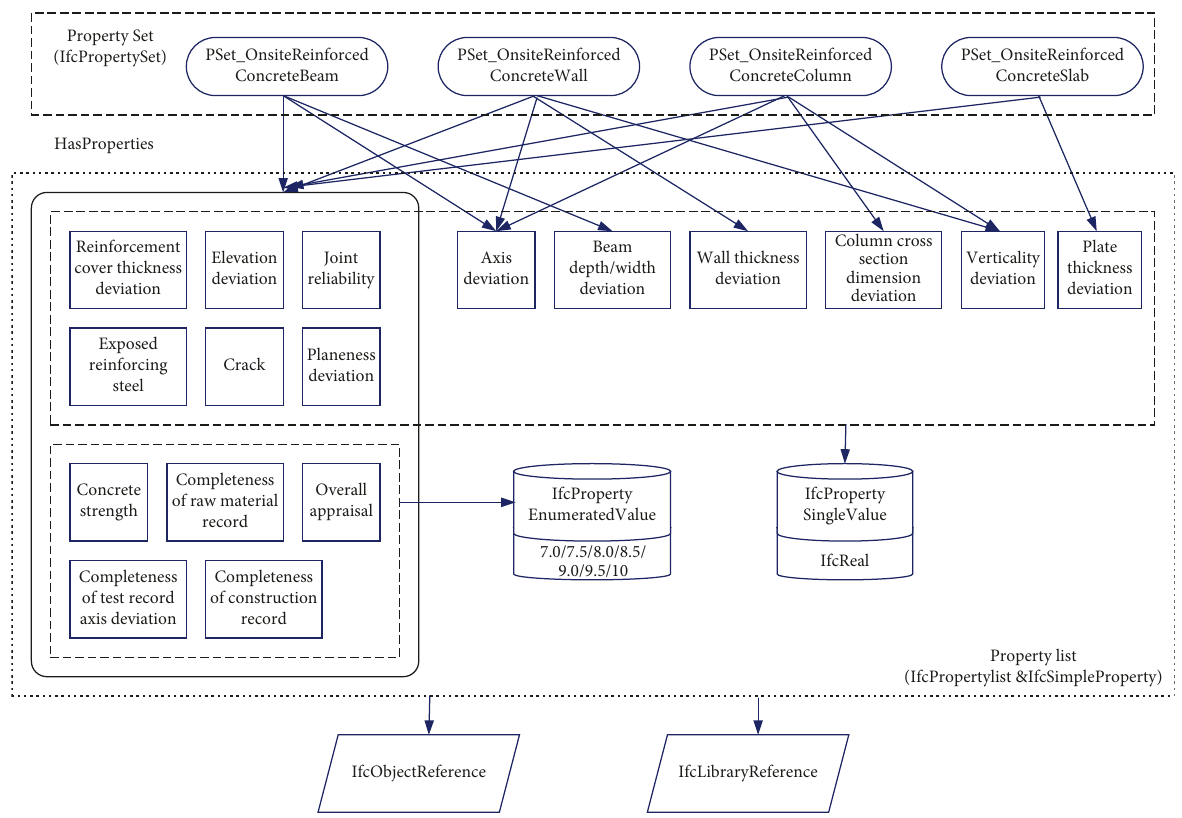
Figure 5: Instance model of